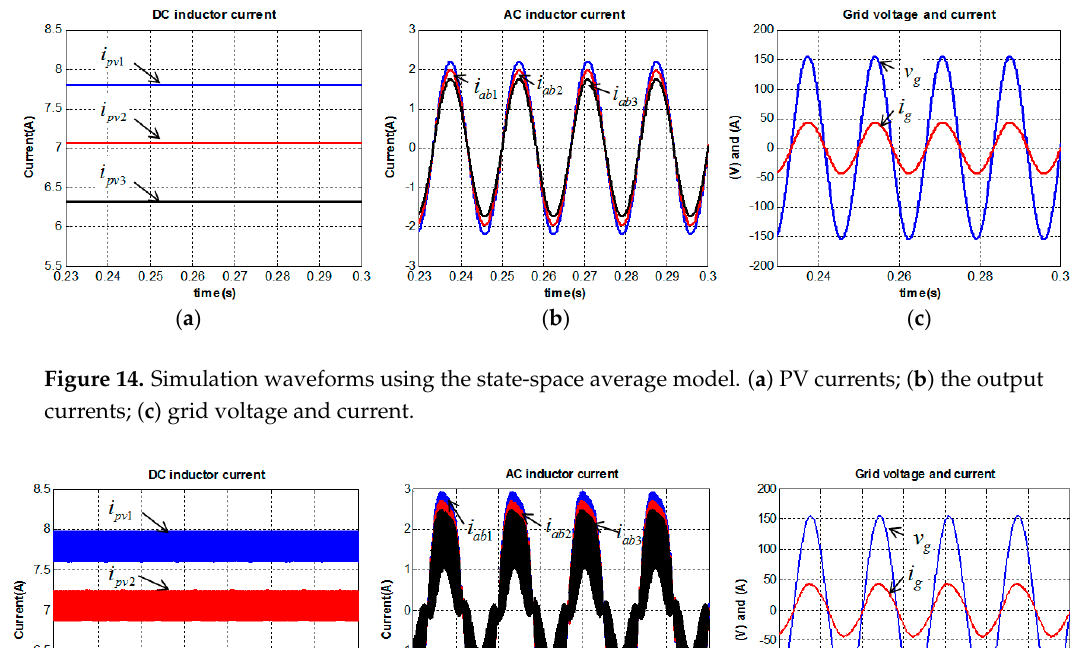
Figure 15. Simulation waveforms using the dynamic switching model. ( a ) PV currents; ( b ) the output currents; ( c ) grid voltage and current.